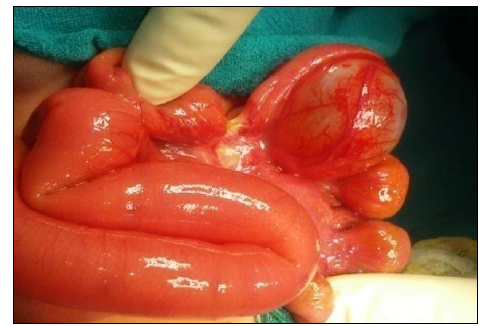
Figure 1: Intra-operative picture showing dilated proximal jejunum with type 2 proximal ileal atresia and distal mesenteric cyst compressing a part of the adjoining ileal